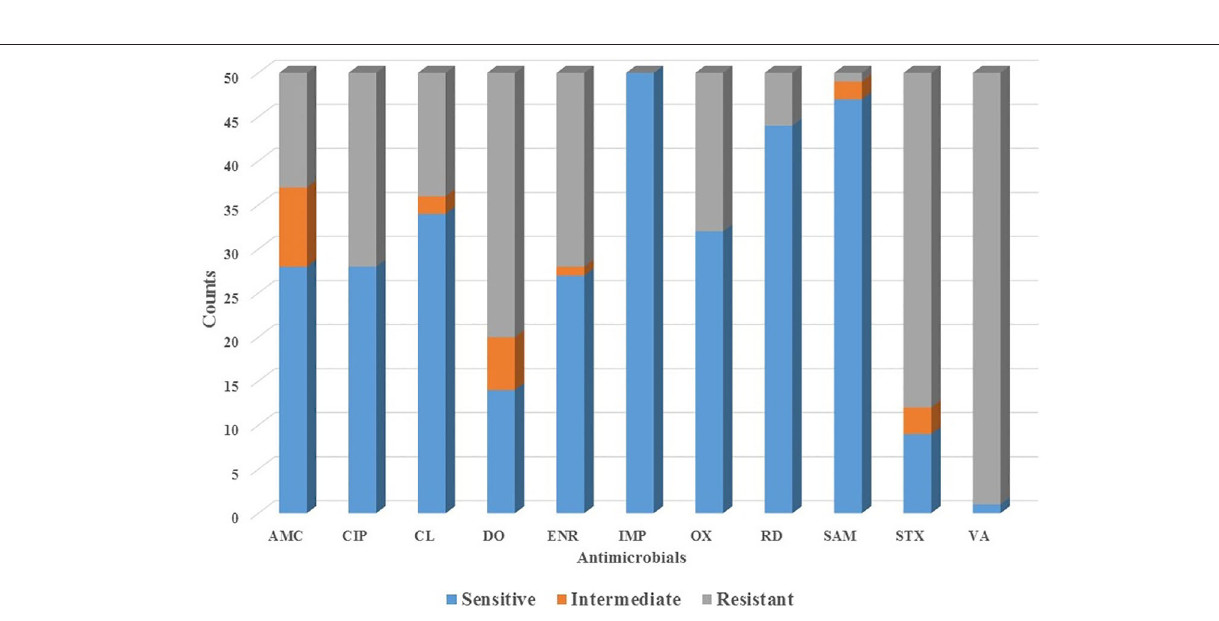
FIGURE 4 | The profile of antimicrobial sensibility of Staphylococcal isolates obtained from canine patients suffering from CSP. AMC, Amoxicillin/Clavulanic acid; CIP, Ciprofloxacin; CL, Cephalexin; DO, Doxycycline; ENR, Enrofloxacin; IPM, Imipenem; OX, Oxacillin; SAM, Ampicillin/Sulbactam; VA, Vancomycin; RM, Rifampicin; TMX,